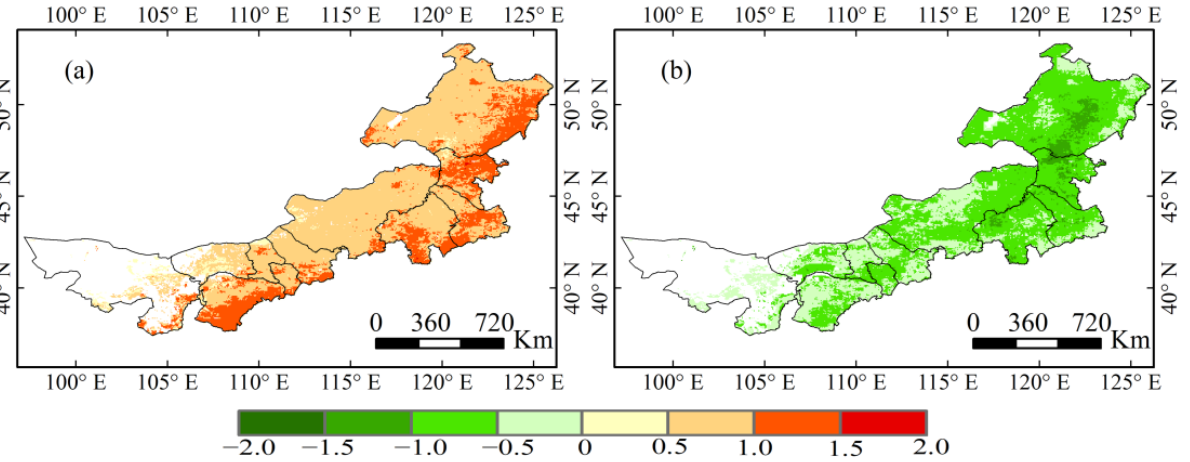
Figure 7. Spatial distribution of sensitivity coefficients of ( a ) GPP and ( b ) ET to WUE in Inner Mon- golia.